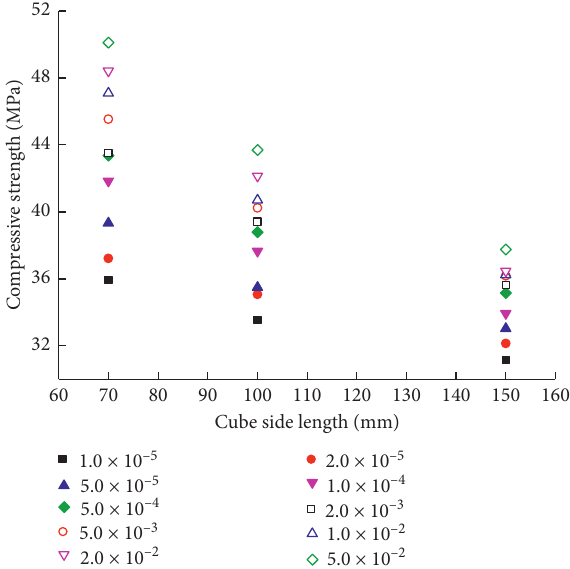
Figure 9: Relationship between cube length and compressive strength.